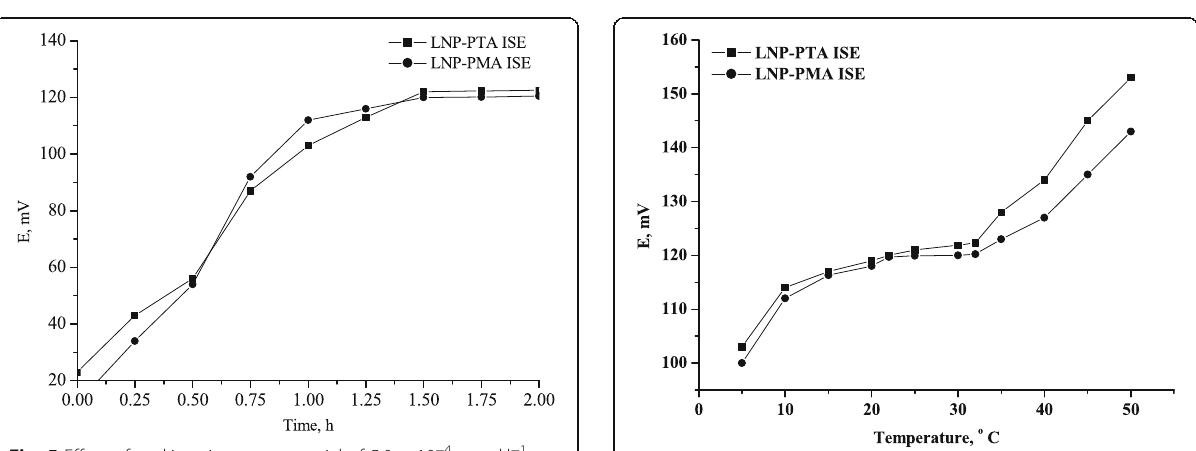
Fig. 7 Effect of temperature on potential of 5.0 × 10 − 4 mmol l − 1 LNP for LNP-PTA and LNP-PMA ISEs